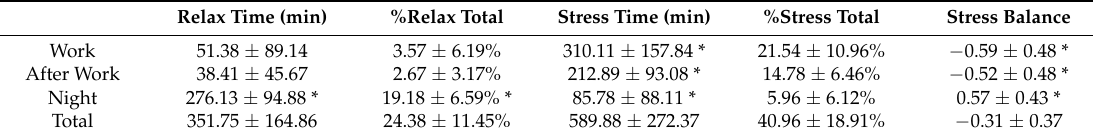
Table 2. Descriptive analysis of the physiological load and recovery (Med ±